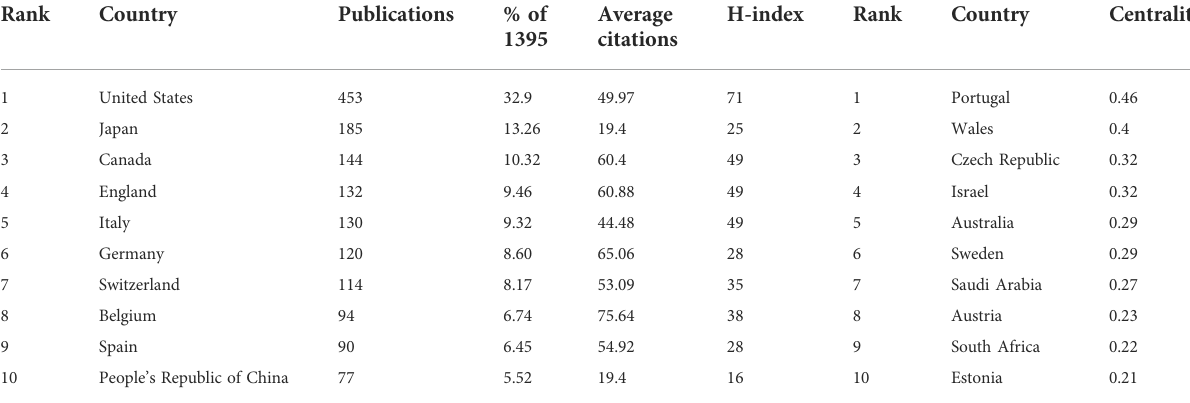
TABLE 1 Top 10 countries and regions in terms of publication volume and centrality.